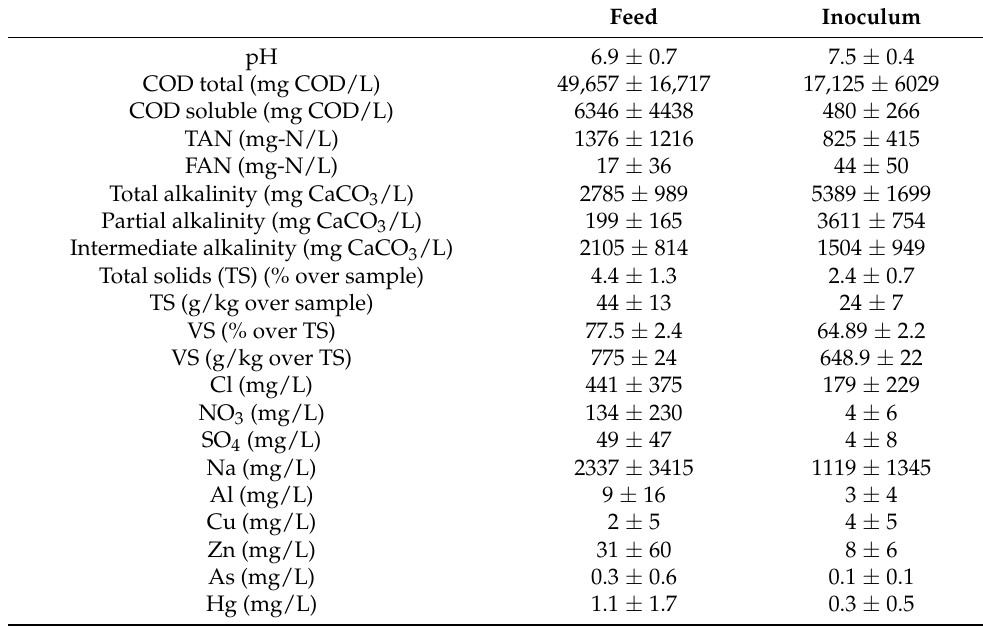
Table 1. Characteristics of the feed and inoculum used for the BMP